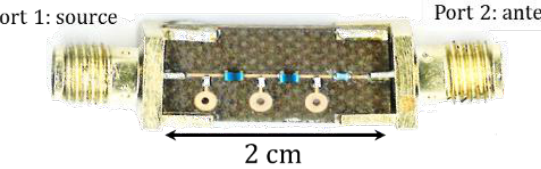
Figure 14. Realized matching circuit of the antenna A5.